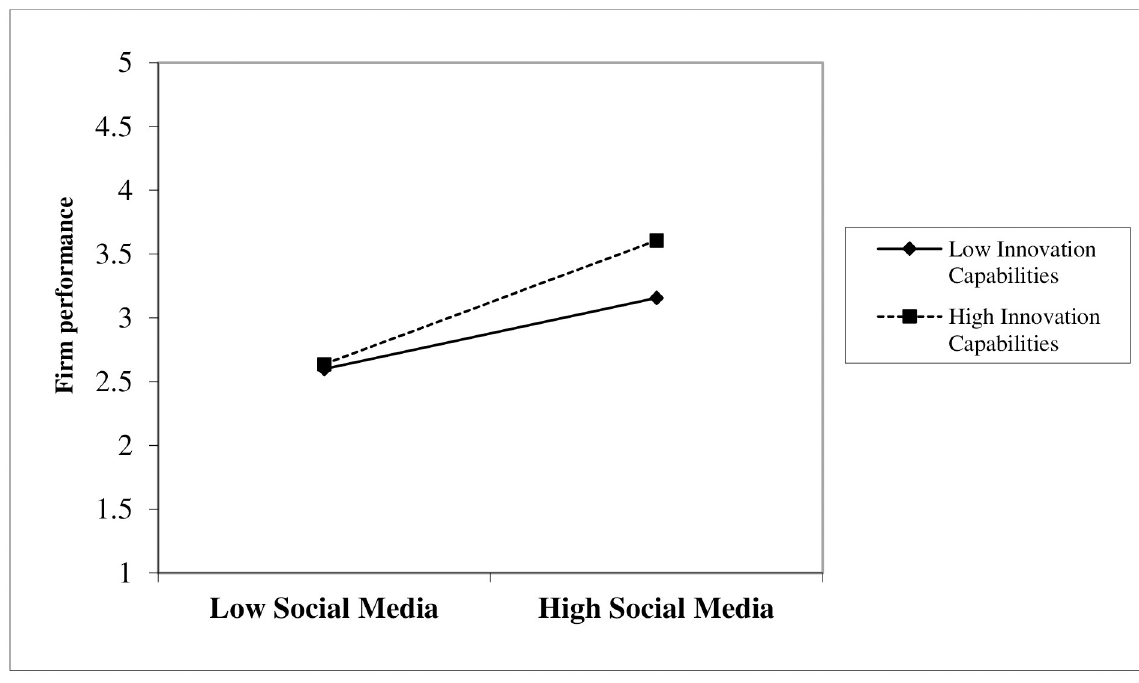
Fig 4. Moderation